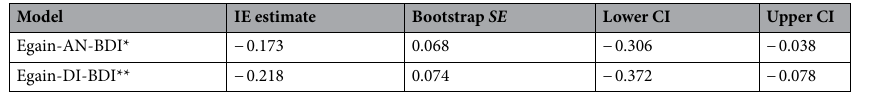
Table 4. Results from the simple mediator models. CI confidence interval, IE indirect effect, Egain gain- feedback-locked ERP component, AN Anhedonia, DI Distractibility, BDI Beck Depression Inventory. * p < 0.05; ** p < 0.01.